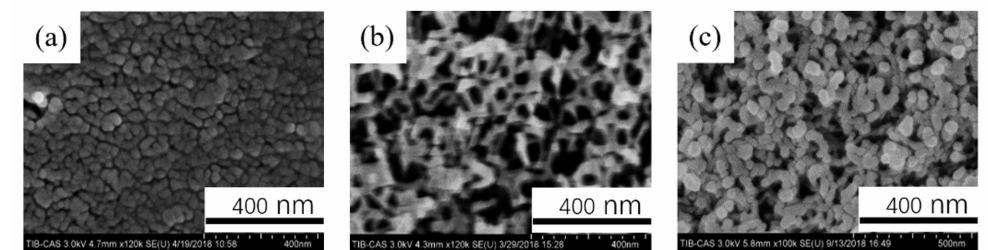
Figure 6. SEM images of 2024 anodic oxide films at different anodic oxidation temperatures: ( a ) 3 °C; ( b ) 21 °C; ( c ) 25 °C.